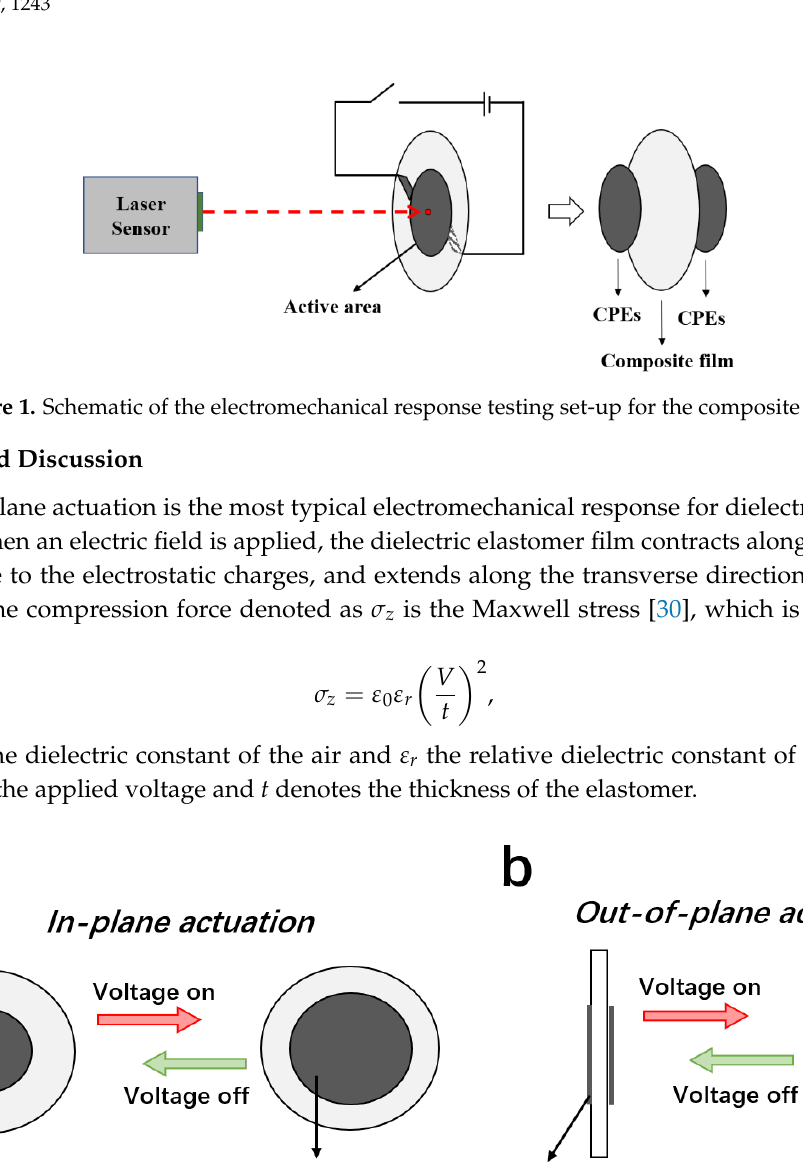
Figure 1. Schematic of the electromechanical response testing set-up for the composite films.